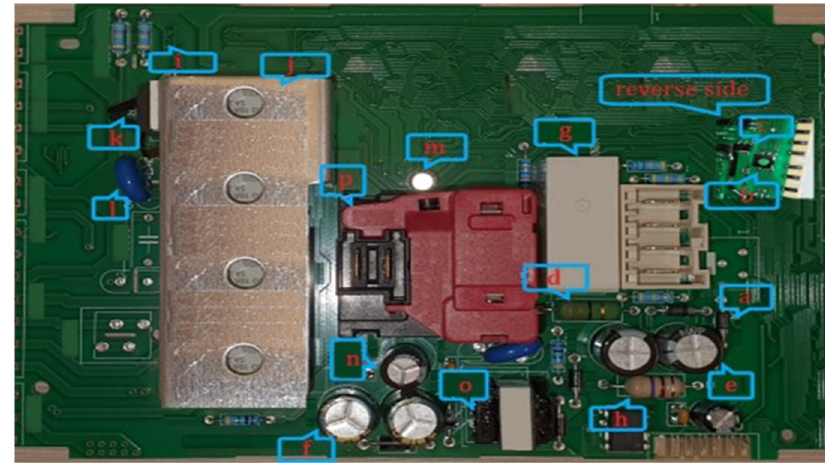
Figure 1. Washing machine PCB and its components. Table 2. Number and cost of PCB components.